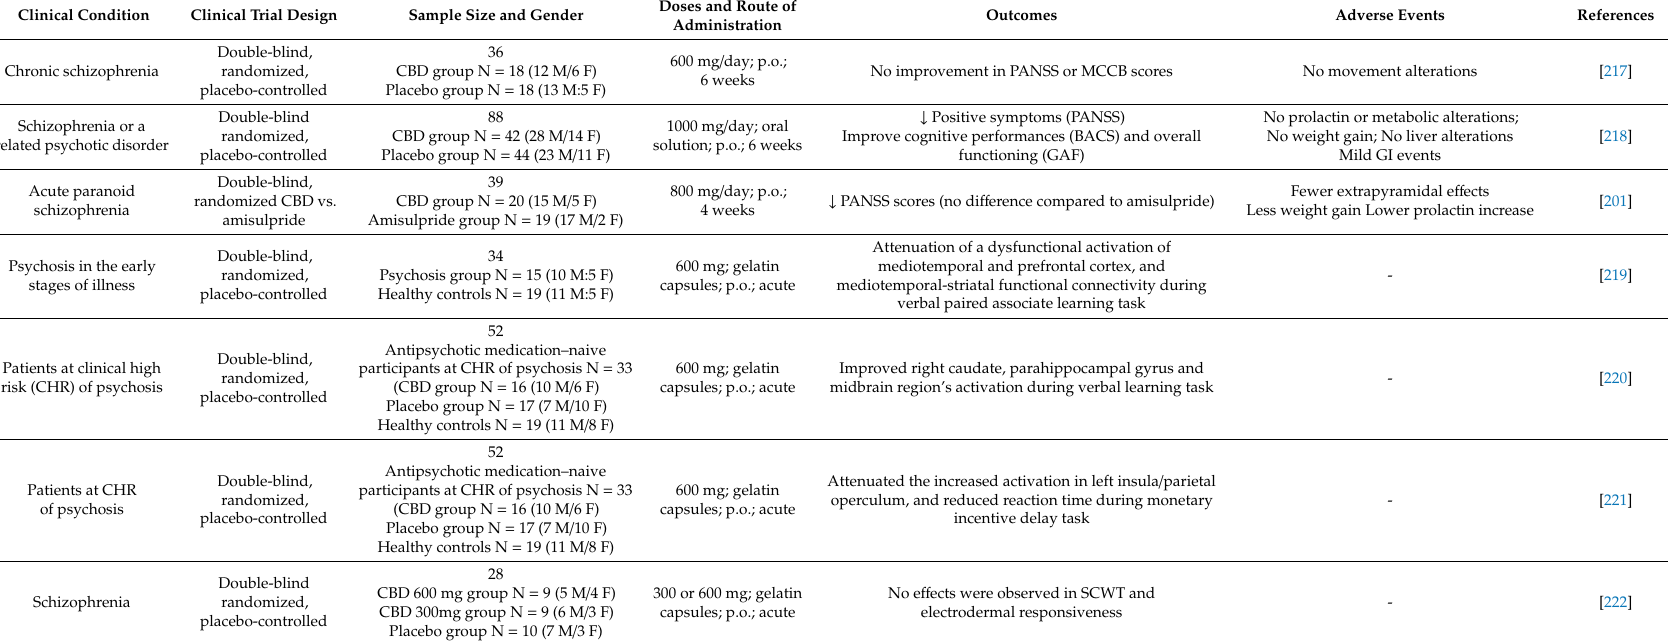
Table 5. Main outcomes achieve from clinical trials in psychosis and